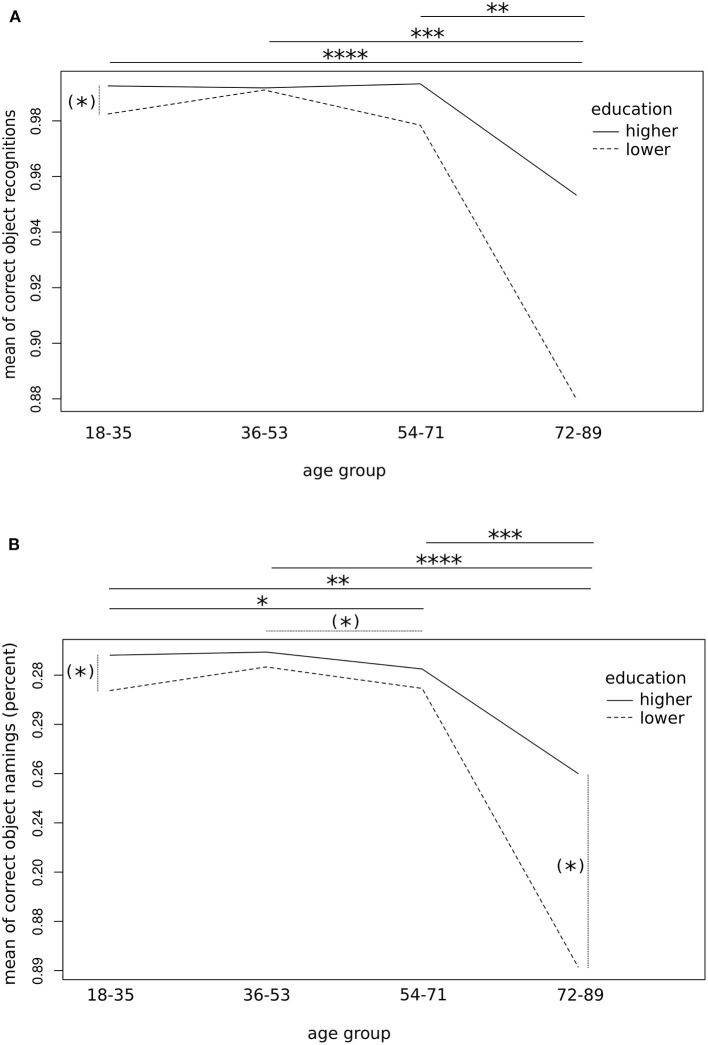
Influence of age group on object naming performance. Interaction plots showing average correctness of object recognition (A) and naming (B) by age groups and education level (i.e., with/without university admission diploma or equivalent). Pooled data of both runs per 100 trials are provided. Significant differences according to groupwise post-hoc comparison of means followed by FDR correction are indicated by asterisks [(*)p < 0.1; *p < 0.05; **p < 0.01, ***p < 0.001, ****p < 0.0001]. Please note the limited ranges of the y-axis, for better readability.